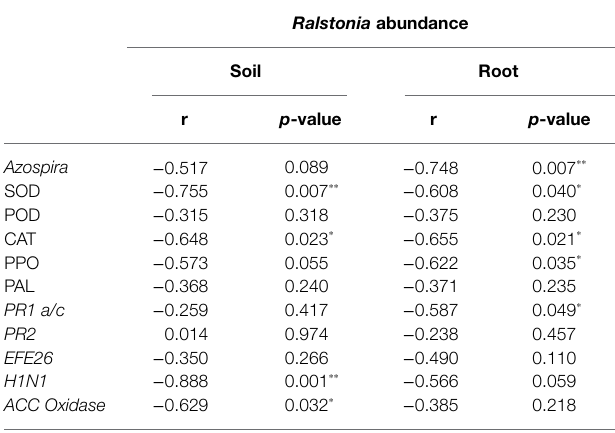
TABLE 3 | Correlations between the relative abundance of Ralstonia and the relative abundance of Azospira , defense-related enzymes activity, and the relative expression levels of defense signaling marker genes in the inoculation